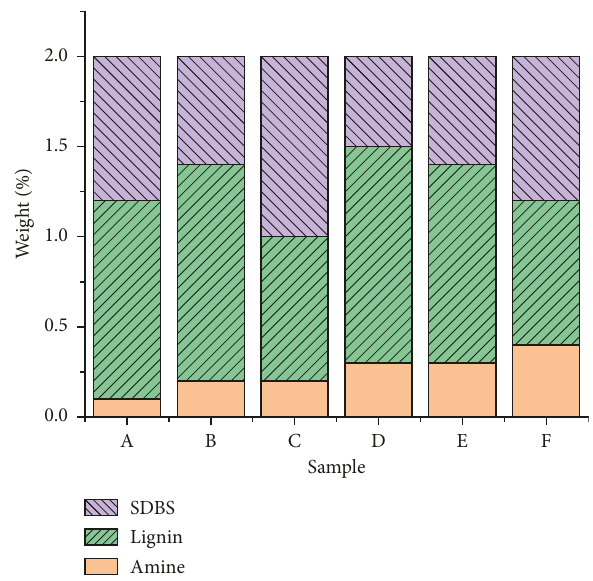
Figure 3: The surfactant mixture composition made up of lignin, SDBS, and amine.